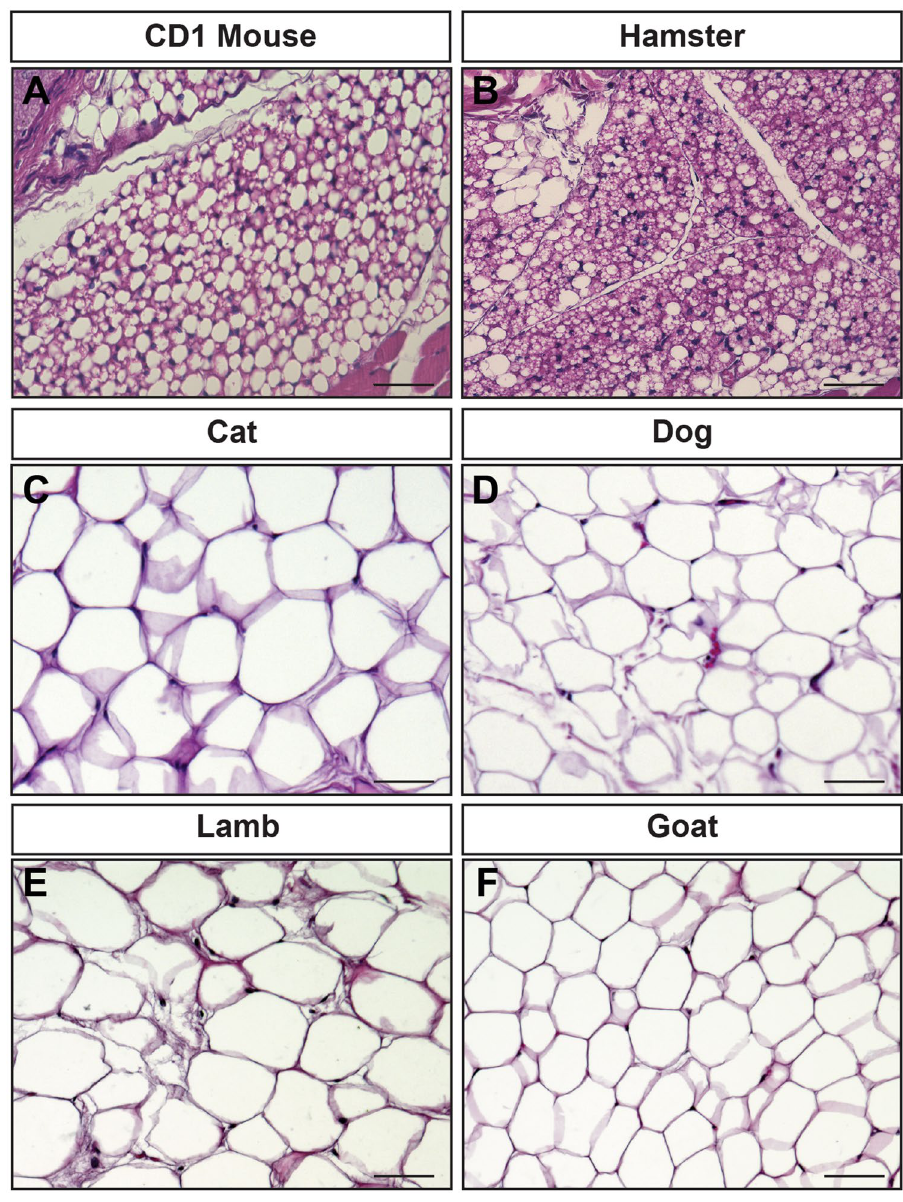
Figure 3. Histologic analysis of orbital fat from different species reveals that brown fat is present in rodent species, but not the other mammals examined. ( A ) H&E stained section of CD1 mouse orbital fat demonstrates a mixture of cells with small lipid vacuoles interspersed with cells with large, single lipid vacuoles. ( B ) H&E stained section of hamster orbital fat reveals the presence of adipose cells containing multiple small lipid vacuoles. ( C ) H&E stained section of cat orbital adipose tissue reveals cells with large lipid vacuoles. ( D ) H&E stained section of dog orbital fat reveals cells with large lipid vacuoles. ( E ) H&E stained section of lamb orbital fat reveals cells with large lipid vacuoles. ( F ) H&E stained section of goat orbital adipose tissue reveals cells with large lipid vacuoles. Scale bars = 50